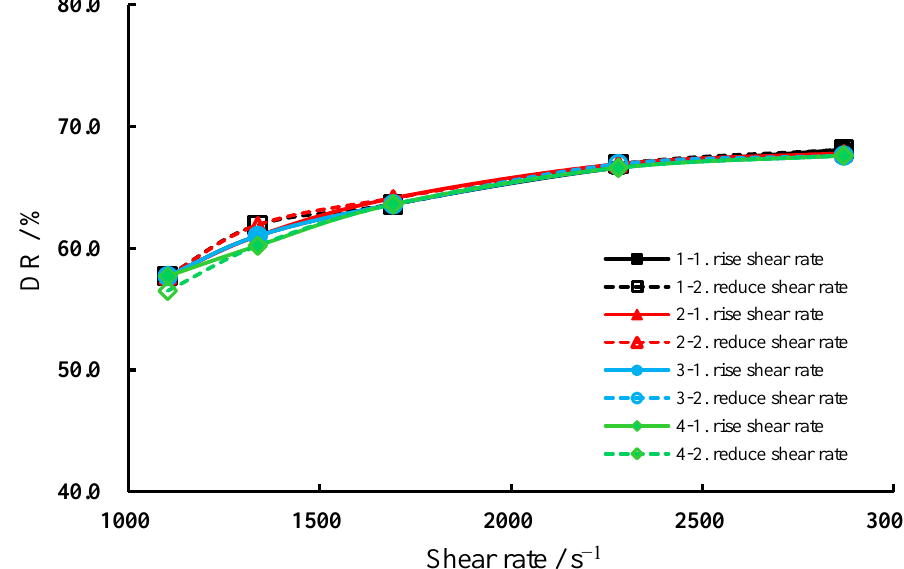
Figure 5. Variations of drag-reduction rate with low shear rate (controlled below 2900 s − 1 ).